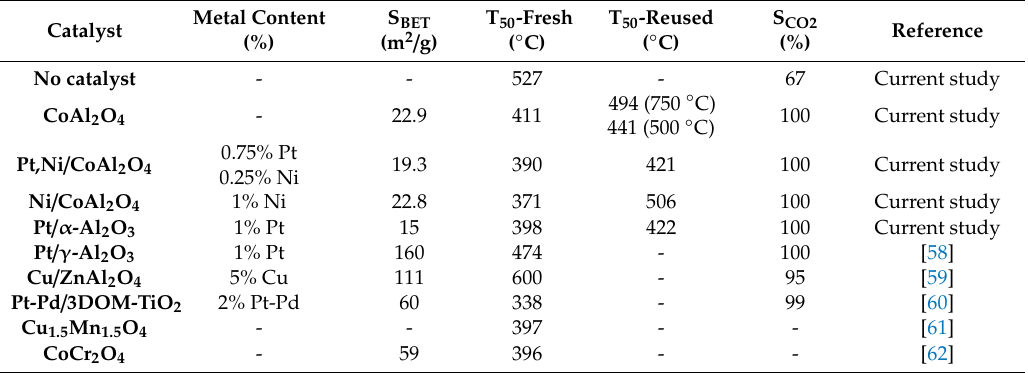
Table 1 compiles the values of specific surface area, T 50, and S CO2 of CoAl 2 O 4 , Ni / CoAl 2 O 4 , Pt,Ni / CoAl 2 O 4, and Pt / α -Al 2 O 3 catalysts, along with bibliographic data for other spinel-type catalysts or supported Pt catalysts with the same platinum loading. The CoAl 2 O 4 -supported Ni and